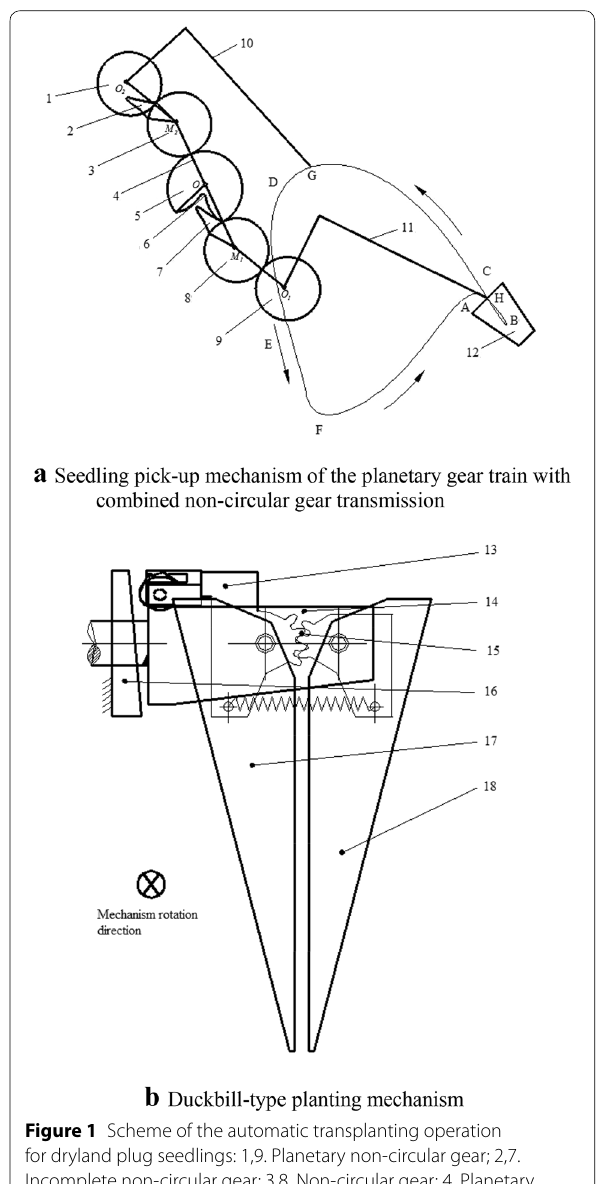
Figure 1 Scheme of the automatic transplanting operation for dryland plug seedlings: 1,9. Planetary non-circular gear; 2,7. Incomplete non-circular gear; 3,8. Non-circular gear; 4. Planetary carrier; 5. Incomplete eccentric circular gear; 6. Incomplete non-circular gear; 10,11. Seedling pick-up arm; 12. Plug seedling tray; 13. Roller rod; 14. Holder; 15. Left and right swing gears; 16. End cam; 17. Left planting mouth; 18. Right planting mouth; ABCDEFA: Motion